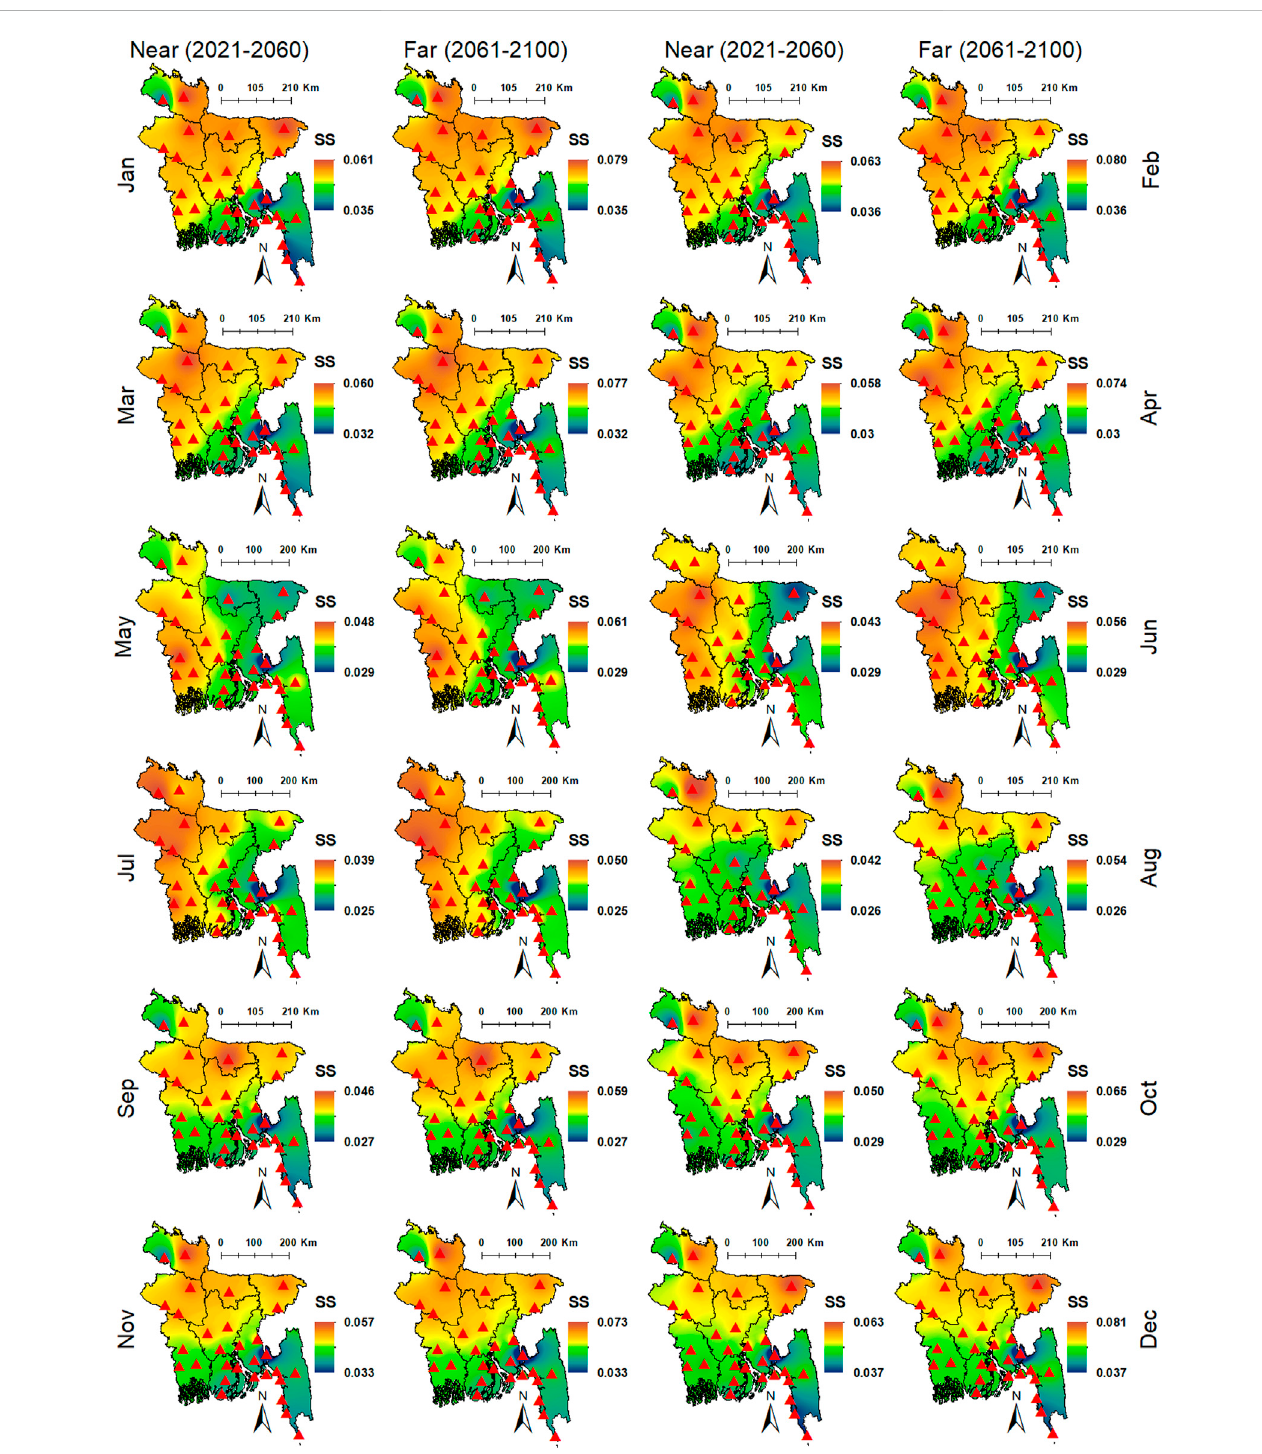
FIGURE 4 Same as Figure 3 but for the